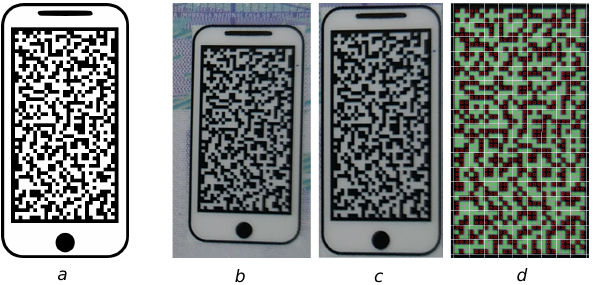
Figure 3. Stages of MRC processing: ( a ) Generated MRC sample to be printed on the ID document; ( b ) detected MRC on the ID document printed sample; ( c ) frontalized MRC image; and ( d ) MRC message reconstruction